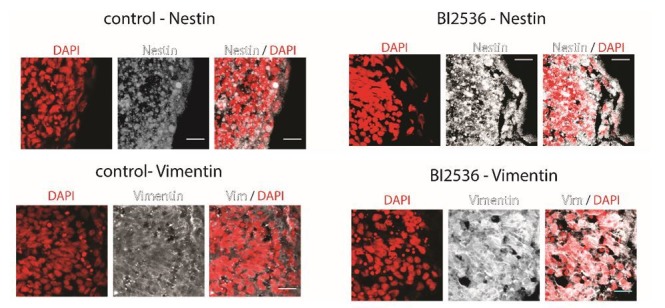
Coronal brain sections of stage 37/38 Xenopus embryos stained for DAPI (red) and Nestin (above) or Vimentin (below) (white).Control animals (left) and BI2536-treated animals (right); the exposed side is on the right hand side of each image. All scale bars are 20 µm.